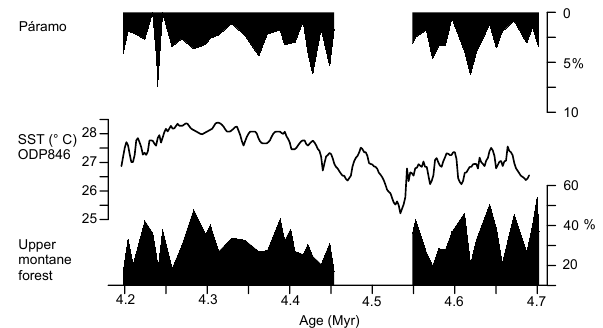
Figure 8. Pollen percentages of upper montane forest and páramo, (cid:48) and U K sea-surface temperature (SST) of ODP Site 846 in the east- 37 ern equatorial Pacific (Lawrence et al.,